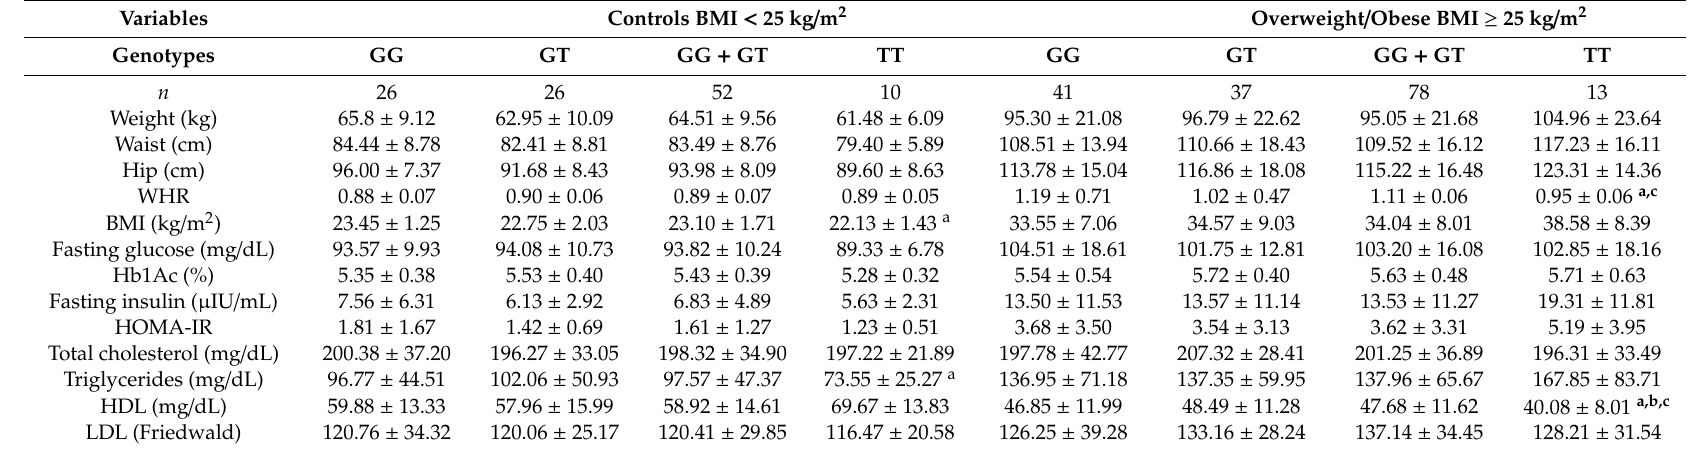
Table 4. General data of all subjects according to the APOA2 rs3813627 genotypes and body mass index